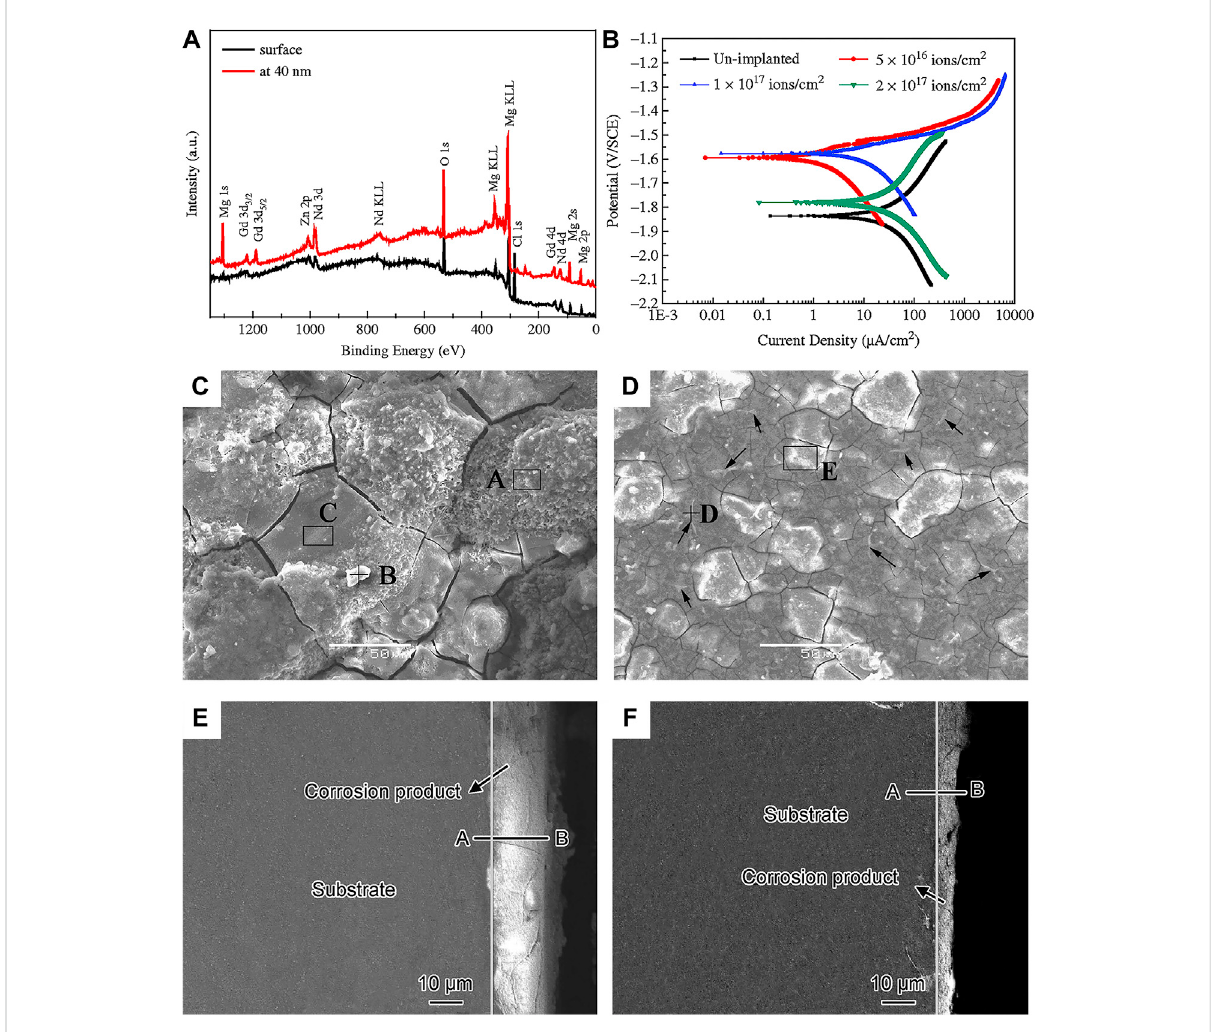
FIGURE 7 (A) XPS spectra of implanted alloy at different depths; (B) polarisation curves of Mg-Gd-Zn-Zr alloy with various doses in SBF solution; surface andcross-sectionmorphologyaftercorrosiontest (C,E) unimplantedand (D,F) Ndimplantedalloy.Reprintedwithpermissionfromreference(Wang et al., 2015b),